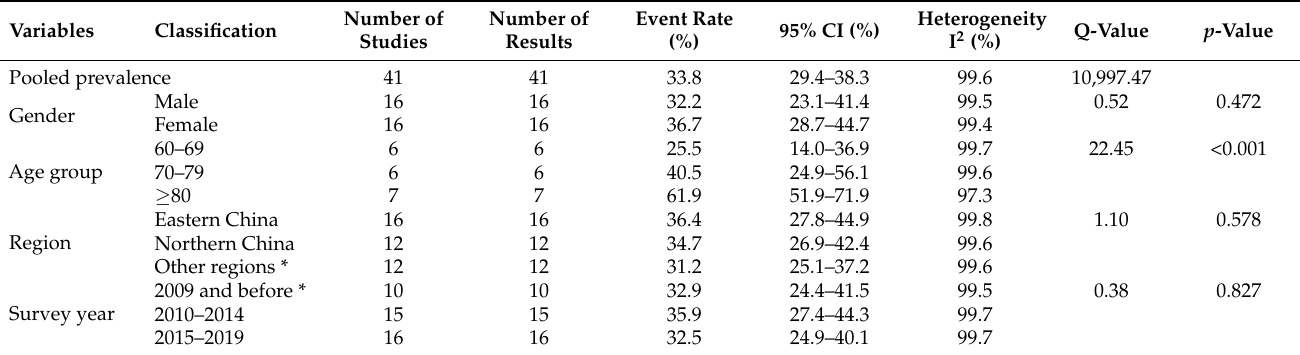
Table 4. Pooled prevalence of complete ADL and subgroup